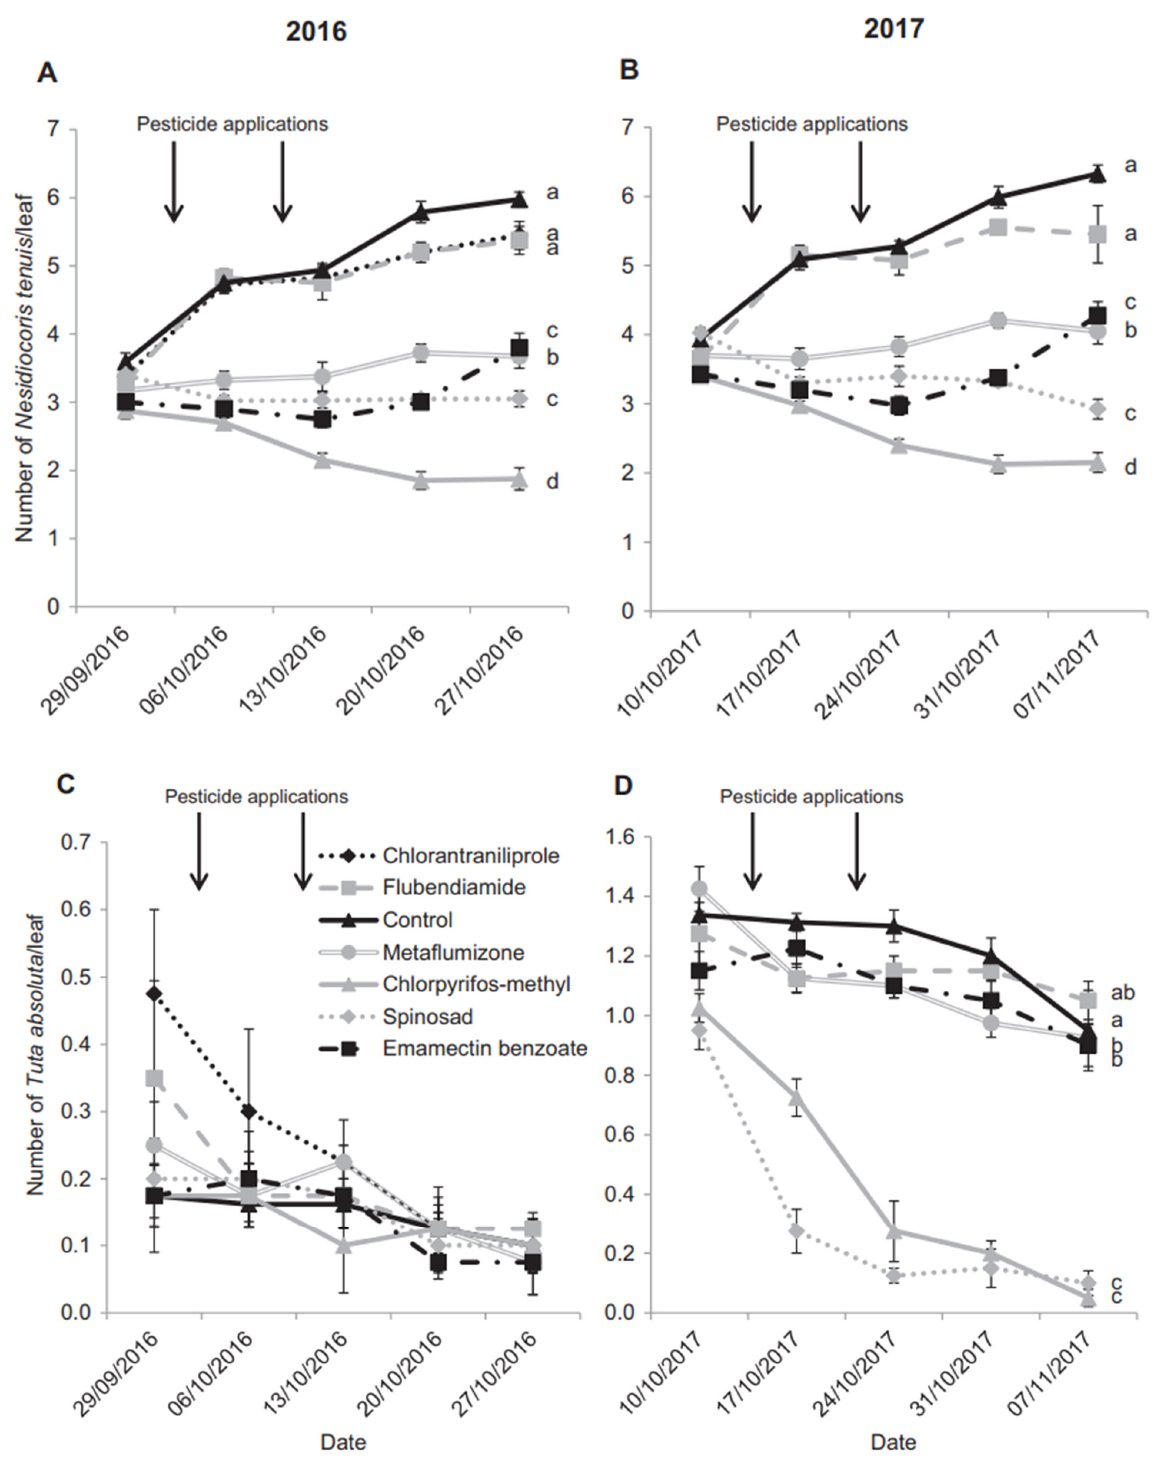
Figure 6. ( A , C ) show the average population of Nesidiocoris tenuis and Tuta absoluta per leaf inside a commercial greenhouse in 2016, and ( B , D ) show the average population of the same pests in 2017 after the pesticide was applied twice in 2016 [61] .